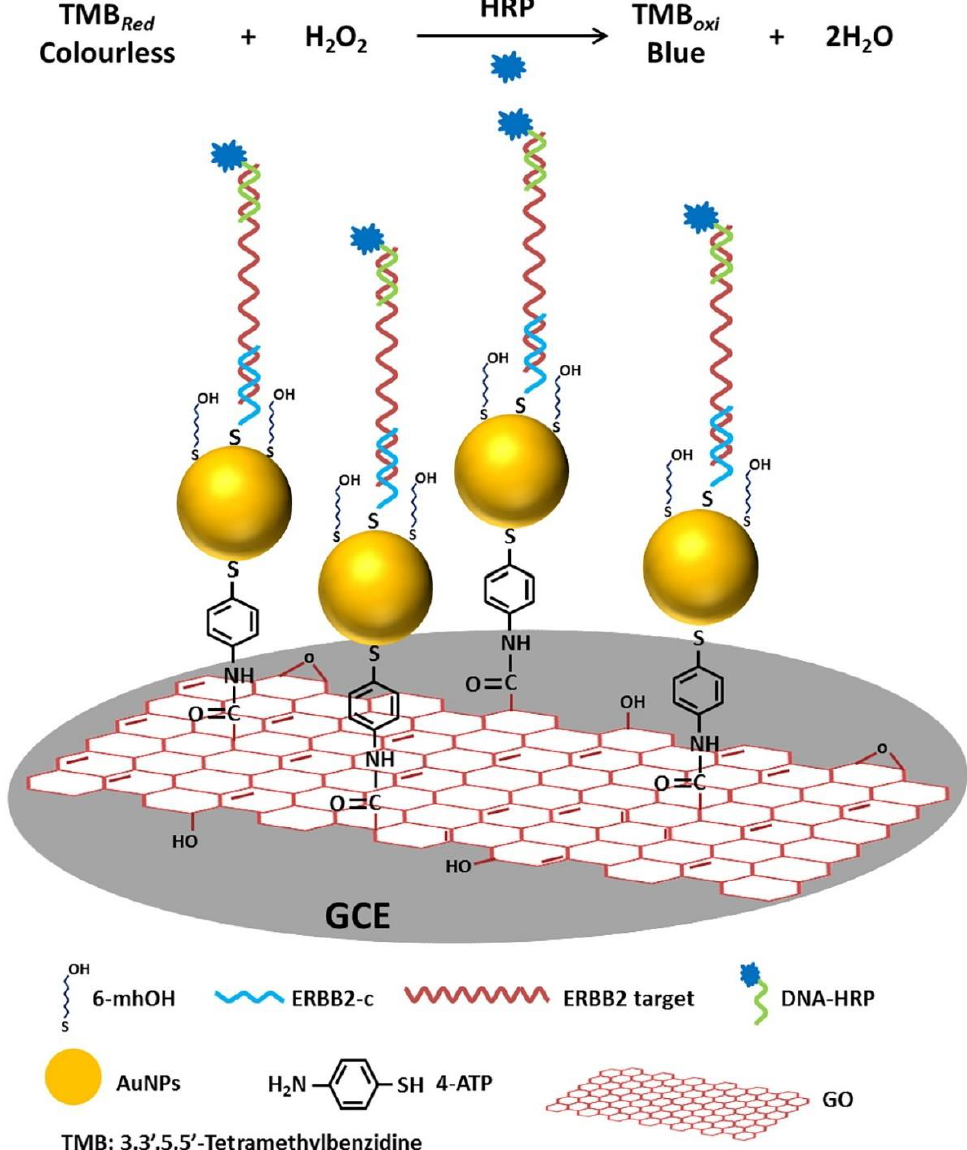
Figure 8. Schematic illustration of a DNA sensor showing the hybrid material consisting of graphene oxide and gold nanoparticles and the hybridization of target DNA